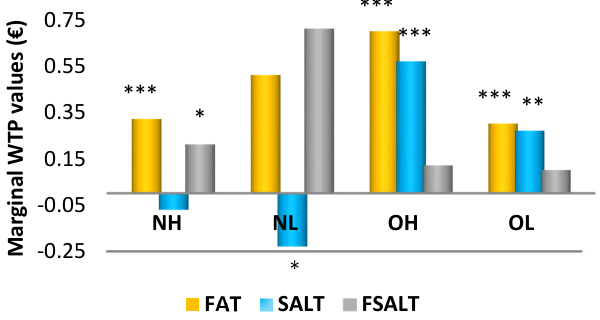
Figure 2. Marginal WTP values ( € /150 g) across four groups. (***), (**), (*) denotes statistical significance at 1%, 5%, and 10% significance. Table 4. Statistical significance from Poe Test across four groups.